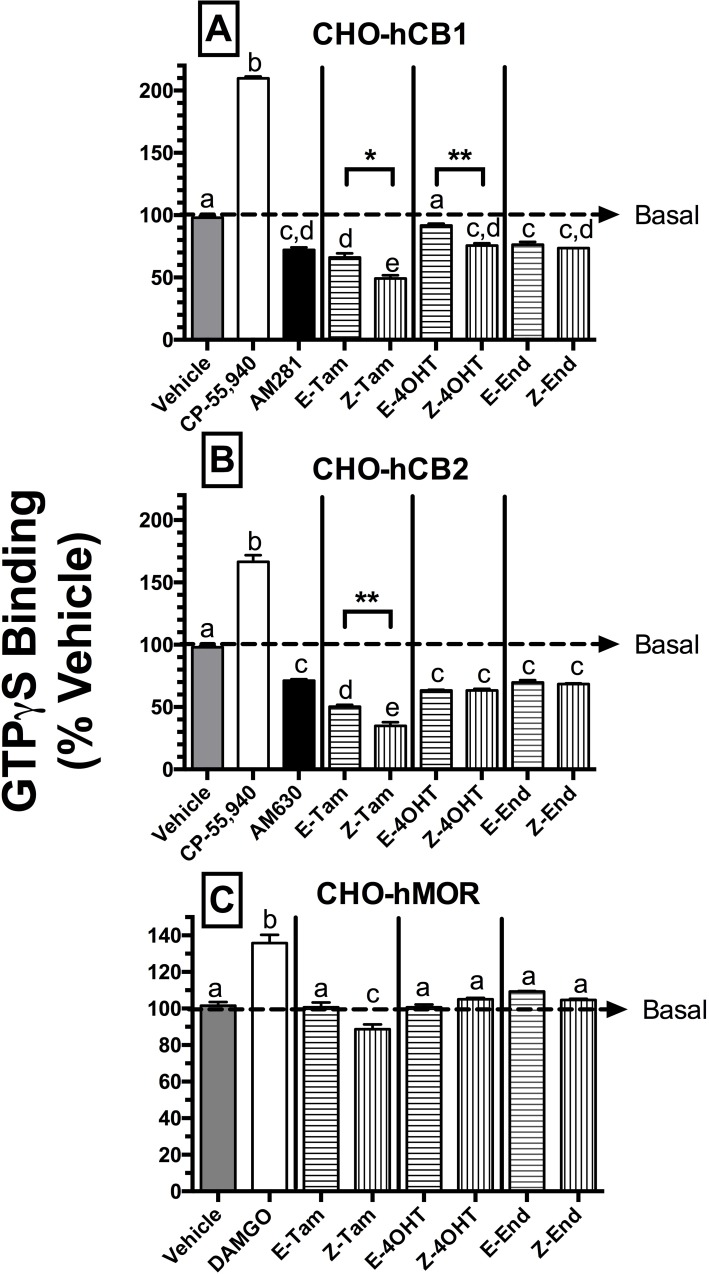
SERM isomers reduce basal G-protein activity via CB1 and CB2Rs.The ability of SERMs to modulate basal G-protein activity via [A] CB1R, [B] CB2R and [C] MORs was evaluated by examining [35S]-GTPγS binding in the presence or absence of a receptor-saturating concentration (10 μM) of all compounds. G-protein modulation by full agonists CP-55,940 (10 μM) and DAMGO (10 μM) was examined to serve as positive controls for activation of [A-B] CBRs and [C] MORs, respectively. G-protein modulation by the inverse agonists AM-281 and AM-630 was examined to serve as positive controls for regulation of [A] CB1 and [B] CB2R signaling. The mean ± SEM of [35S]GTPγS binding is presented as percent of G-protein activity in the presence of vehicle. a,b[35S]GTPγS binding produced by individual SERMs acting at hCB1 [A], hCB2 [B] or hMOR [C] receptors designated by different letters above bars, is significantly different (P<0.05, one-way ANOVA; Tukey Post-hoc test). *,**Bar graphs comparing E and Z isomers of individual SERMs that are designated by asterisks, are significantly different from activity at respective receptors (P<0.05, 0.01; student’s t-test).